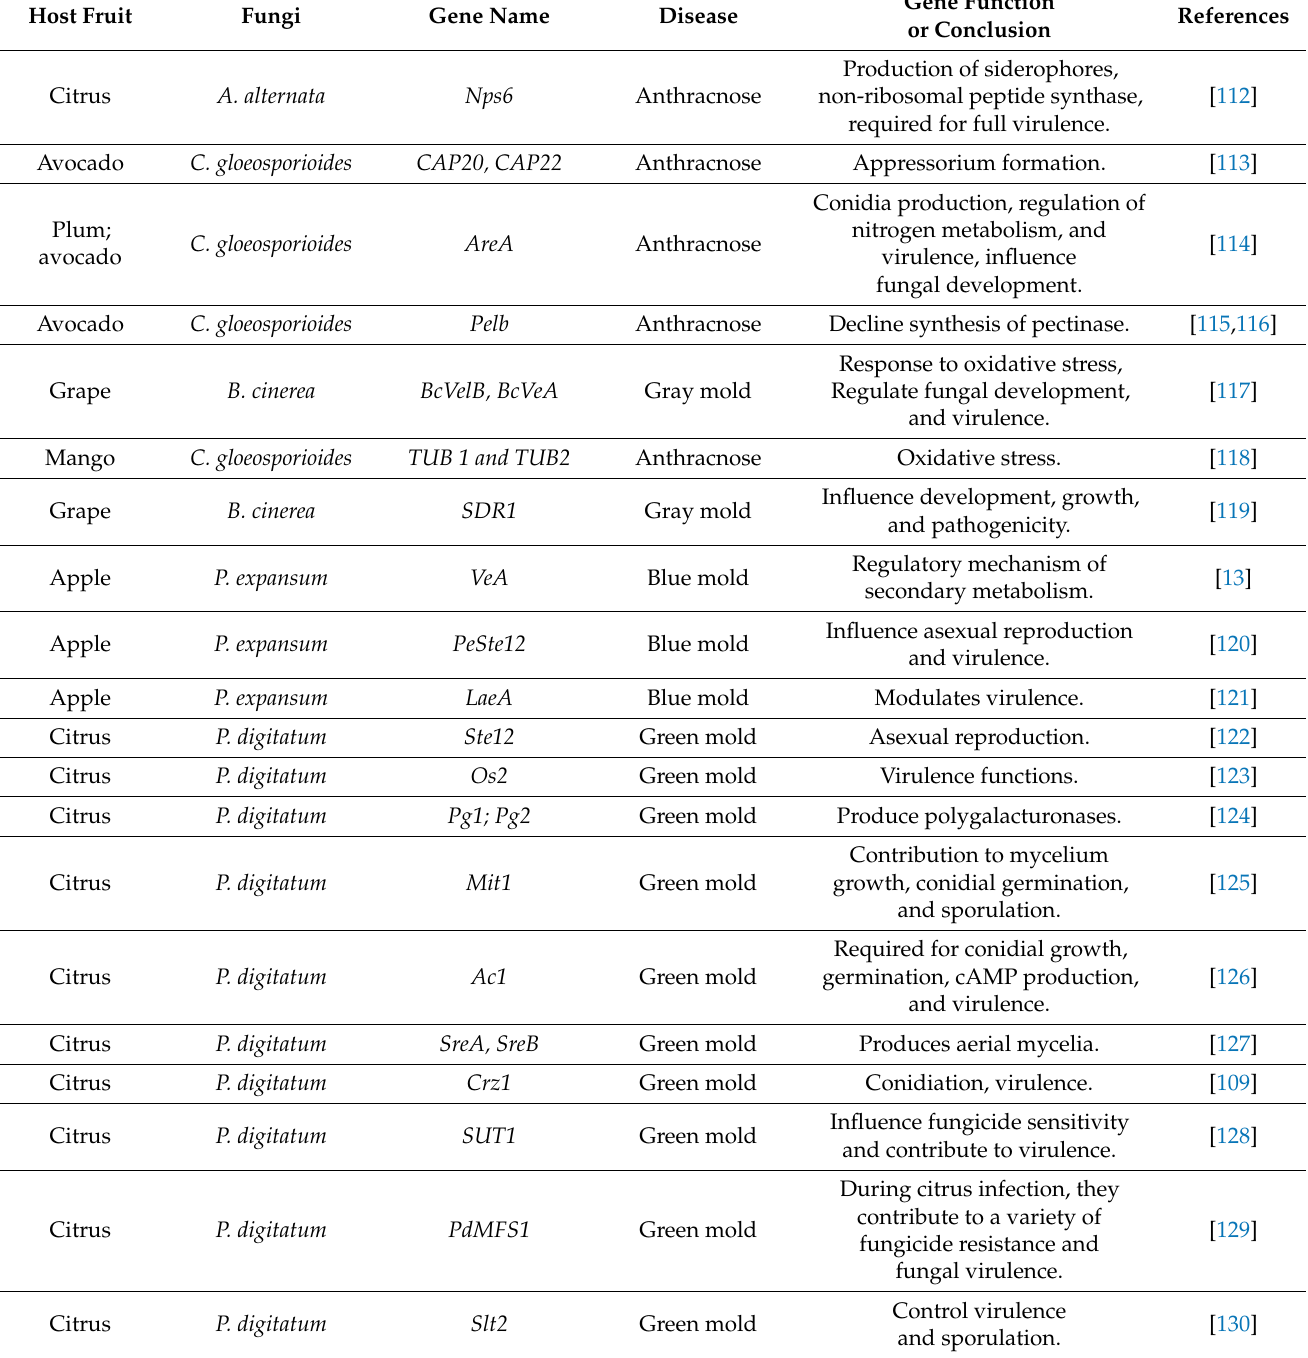
Table 3. Fungal genes involved in postharvest fungal